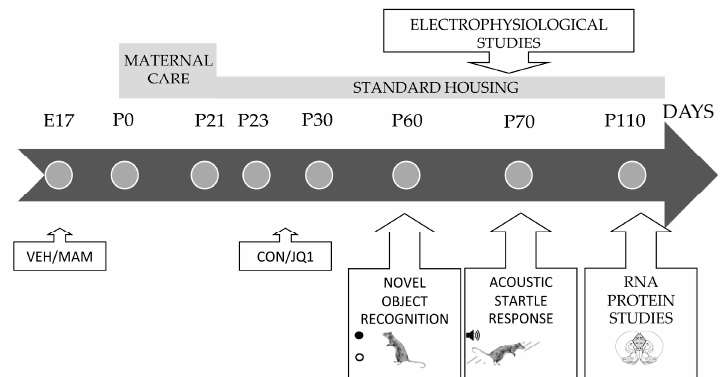
Figure 11. The schematic diagram depicts the adolescent administration of the inhibitor of BET pro- teins, JQ1 or vehicle (CON), of rats treated with vehicle (VEH) or MAM at embryonic day 17 (E17); P (postnatal days of life).